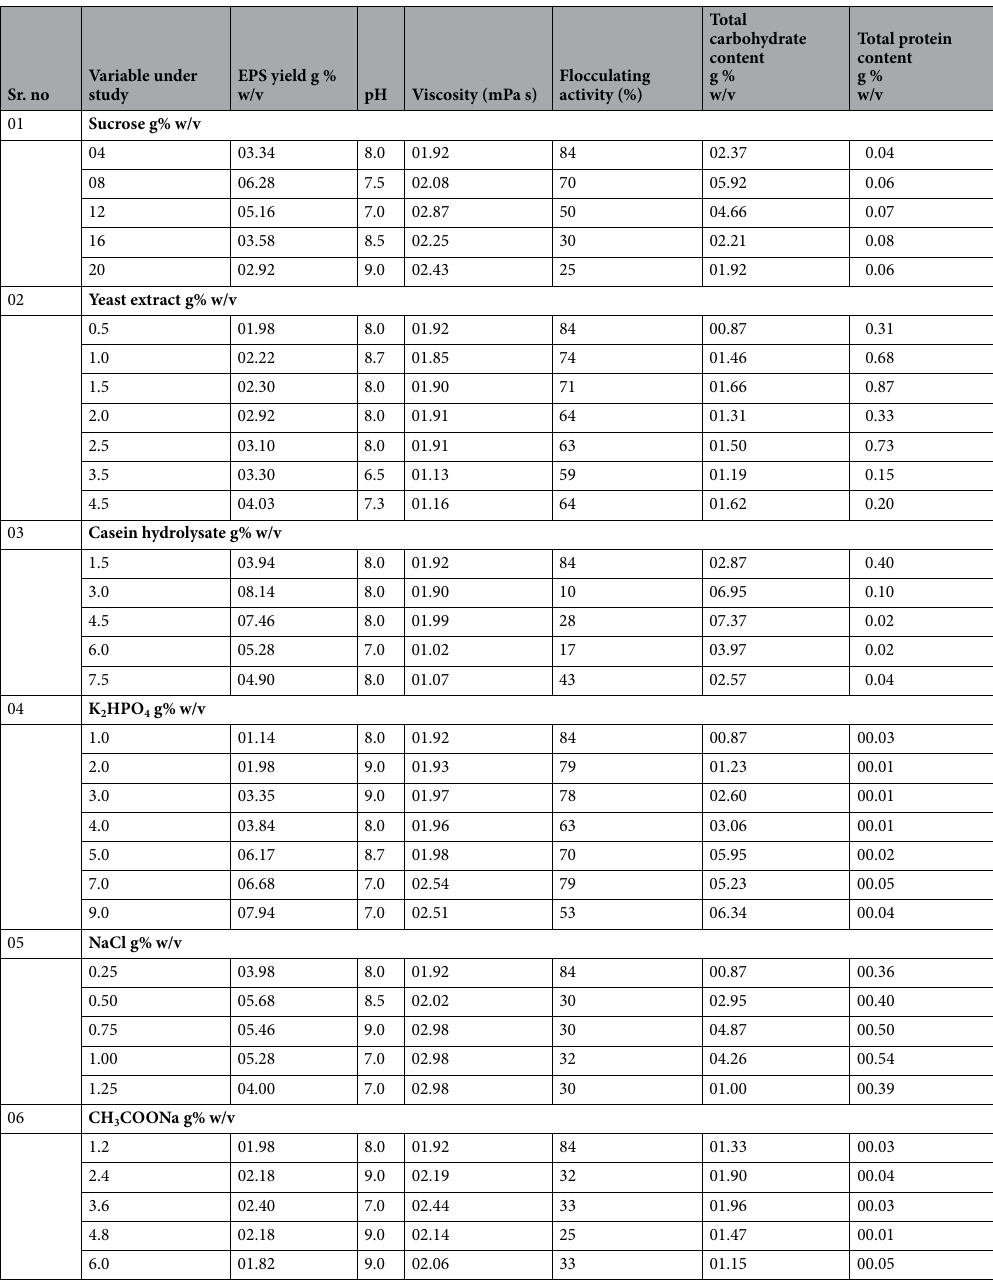
Table 3. Results of effect of EPS medium components on EPS